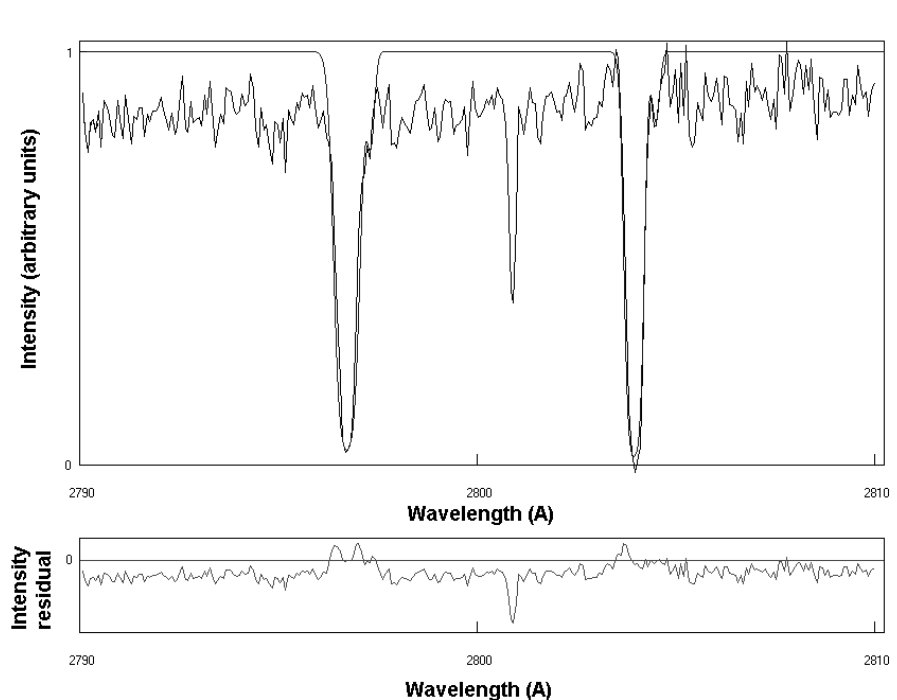
Fig. 1. The UV Mg II resonance lines in the spectrum of HD 52721 with the model fit. The model for each of the Mg II lines consists of two components. The graph at the bottom shows the differences between the model and the observed